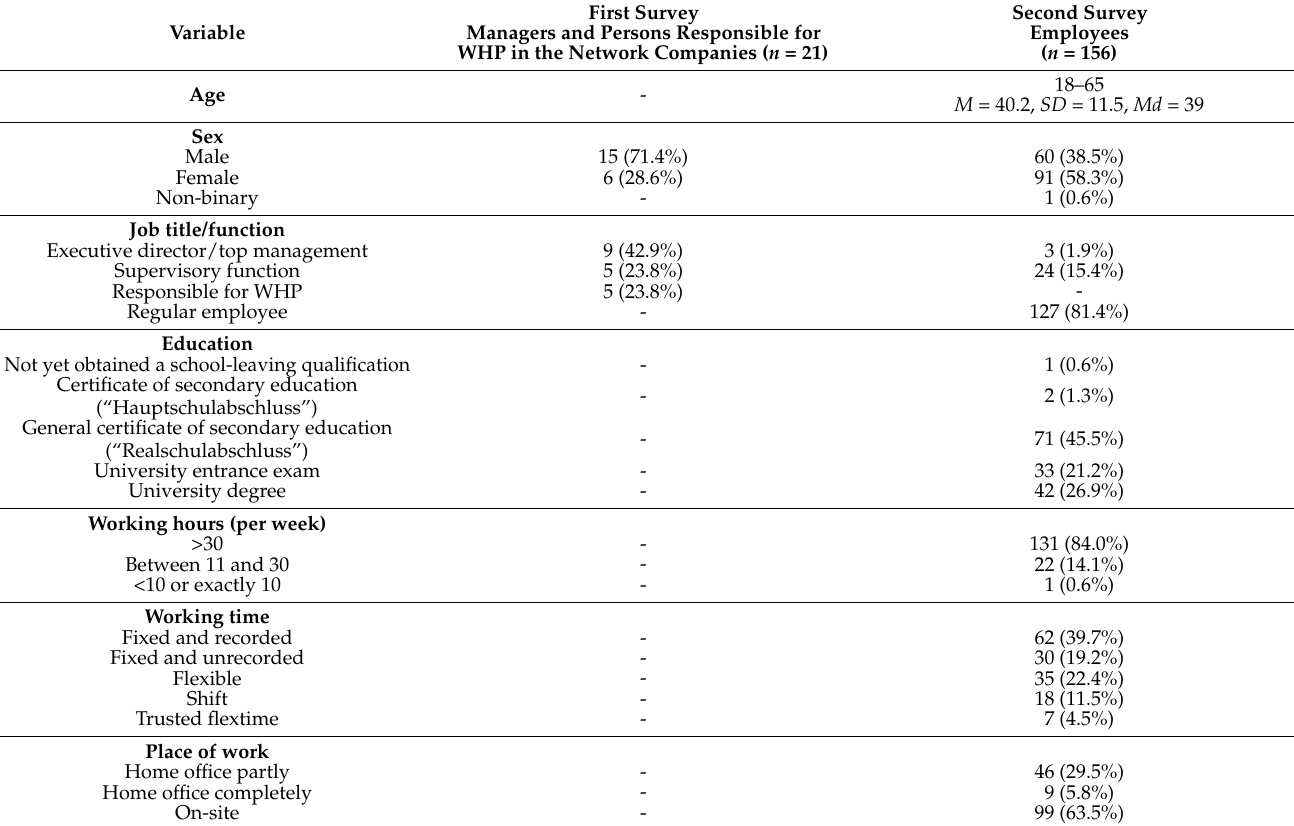
Table 1. Participant characteristics.